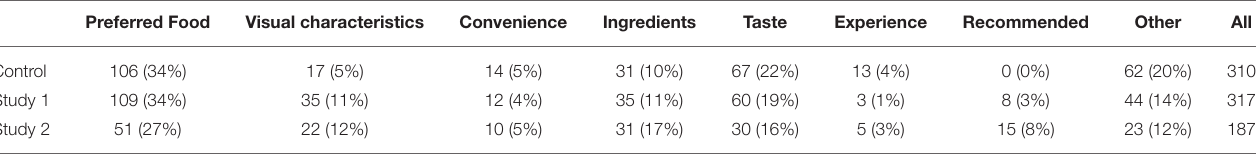
TABLE 7 | Categorized free text explanations after each decision. Preferred